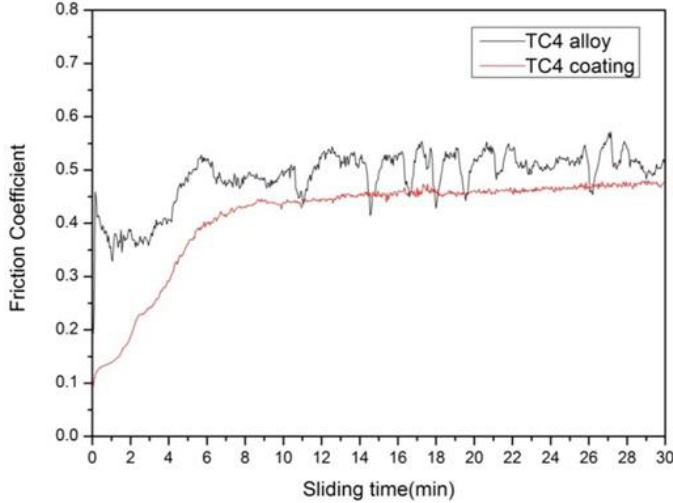
Figure 7. The friction coefficient curves of the coating.